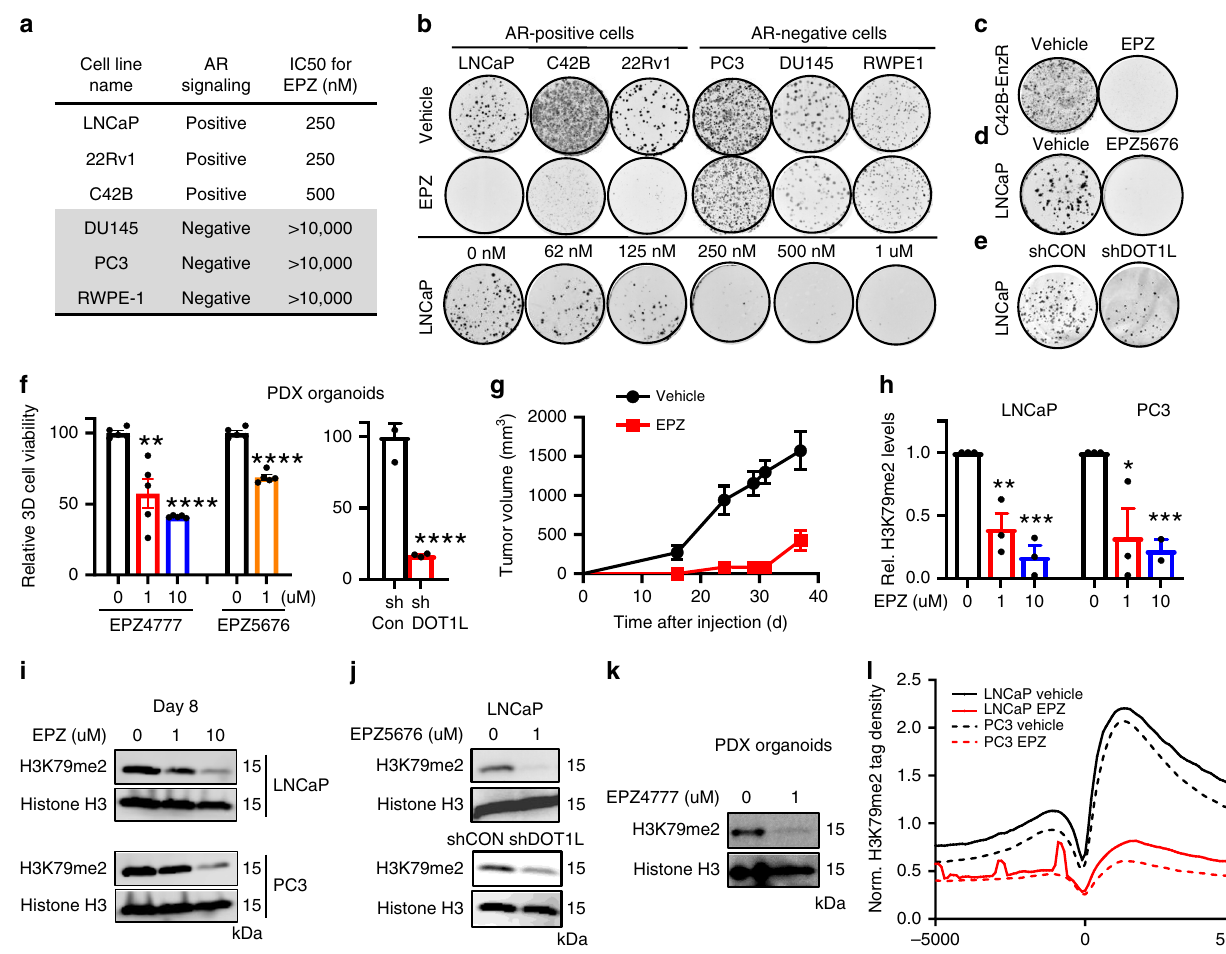
Fig. 2 DOT1L inhibition leads to selective loss in cell viability in AR-positive cells. a Comparison of Half maximum inhibitory concentration (IC50) for EPZ in 6 prostate cancer cell lines. b (Top) Representative images of clonogenic assays performed for 6 prostate cancer cell lines treated with Vehicle or 10 μ M of EPZ for 12 days from 3 independent experiments. (Bottom) Representative images of clonogenic assay in LNCaP cells treated with increasing doses of EPZ for 12 days from 3 independent experiments. Colony formation assays performed in ( c ) C42B-ENZR cells treated with Vehicle or 10 μ M EPZ for 12 days. ( d ) LNCaP cells treated with Vehicle or 10 μ M EPZ5676 for 12 days. e LNCaP cells transduced with shControl or shDOT1L followed by clonogenic assays evaluated after 12 days. f PDX organoids were treated with Vehicle, EPZ (left) or shControl or shDOT1L (middle) and Vehicle or EPZ5676 (right). g LNCaP cells were treated in vitro with Vehicle or 10 μ M EPZ and 2 million viable cells were injected subcutaneously in NOD-SCID mice and tumor growth was monitored ( n = 5 per arm). h , i H3K79me2 western blot analysis performed after 8 days of treatment with Vehicle or EPZ